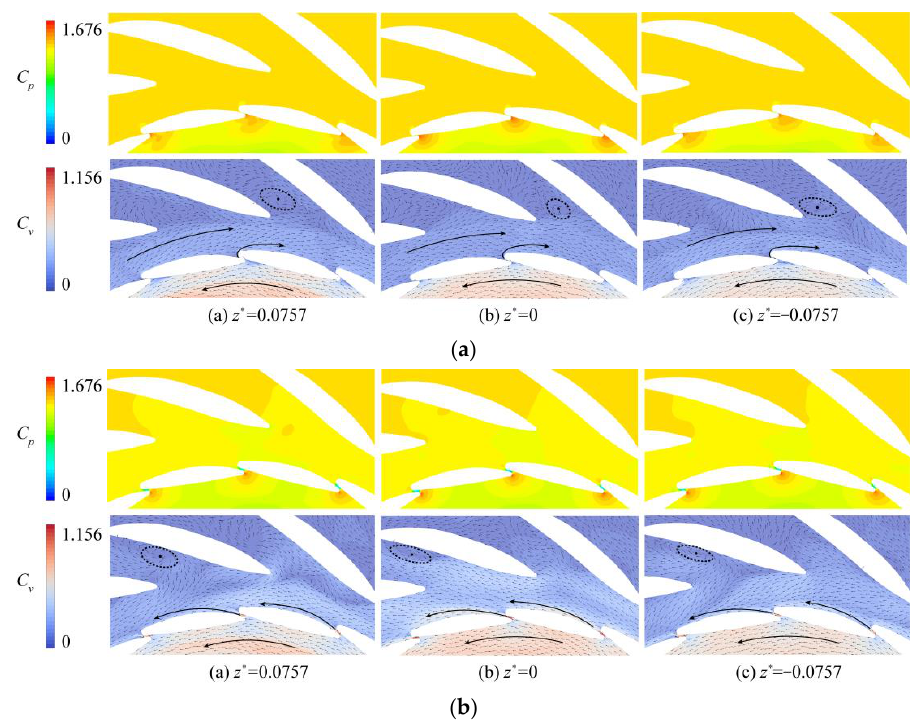
Figure 15. Contours of C p and contours of C v with vectors on the different section planes under the example condition of α = 0.2° and α = 1° at C ψ = 1.133 for GV-O. ( a ) α = 0.2°; ( b ) α = 1°.